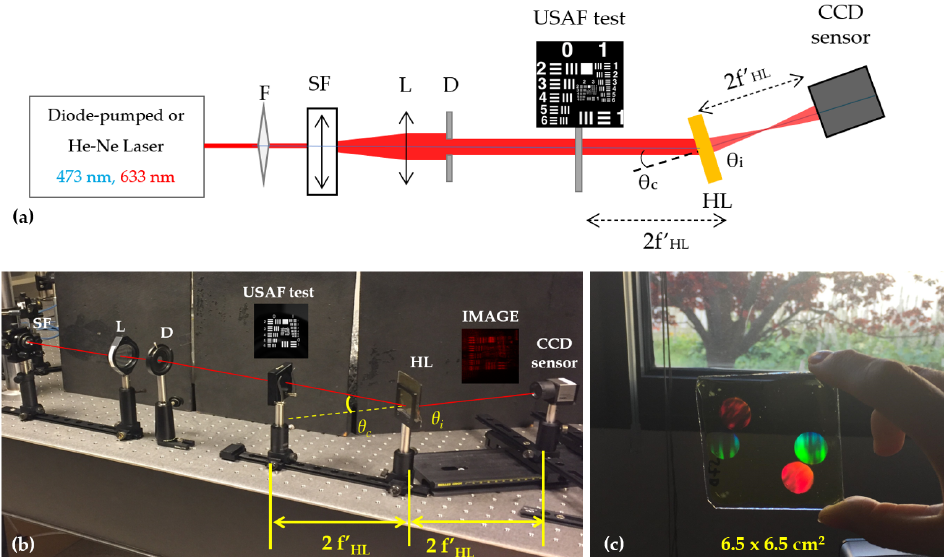
Figure 2. ( a ) Experimental setup for the HLs resolution evaluation. F: filter, SF: spatial filter, L: lens, D: diaphragm, HL: holographic lens, CCD Sensor: Charge Coupled Device. ( b ) Real photo of the experimental setup. ( c ) Picture of HL stored on the photopolymer layer. Video of HL stored on the photopolymer layer can be seen in S1.